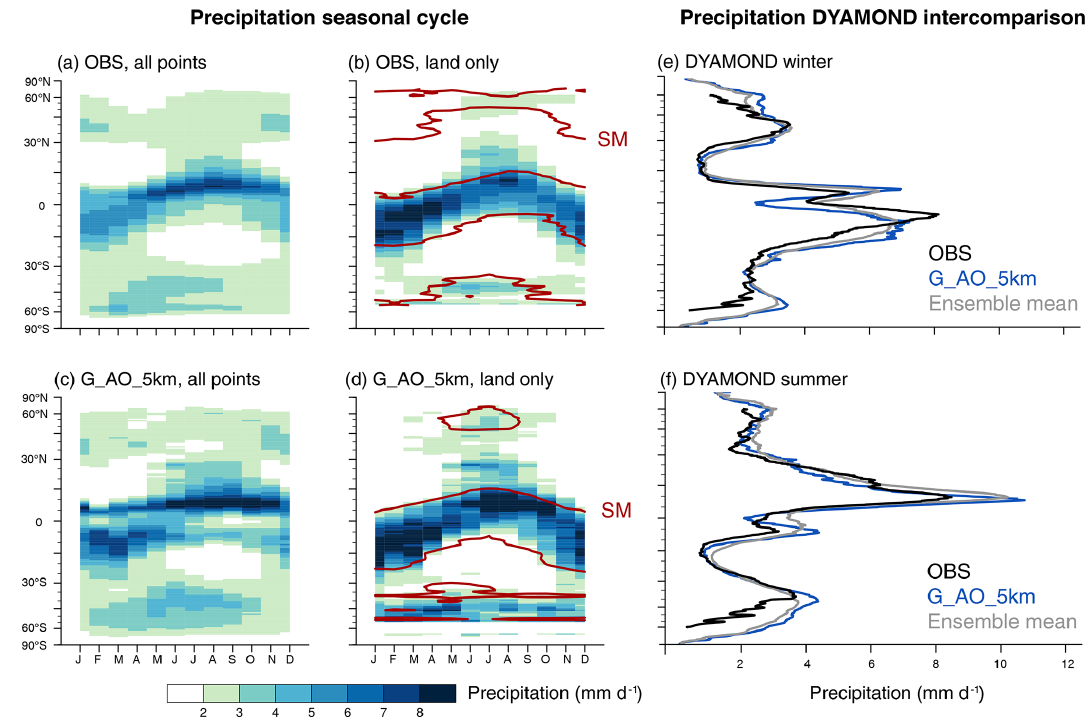
Figure 6. Seasonal evolution of zonal mean precipitation (shading) from (a–b) observations and (c–d) G_AO_5km. In panels (b) and (d) , only land points are included with the soil moisture (SM) contour overlaid in brown (1.5cm in b and 1cm in d given their distinct magnitude). Observations are from the Global Precipitation Climatology Project (GPCP, grid spacing of 2.5 ◦ , Adler et al., 2018) and from the European Space Agency Climate Change Initiative (ESACCI, Dorigo et al., 2017) soil moisture (grid spacing of 0.25 ◦ ) averaged over the years 2010–2019. For G_AO_5km the January and February values are from 2021. Panels (e) – (f) show the zonal mean precipitation from (e) the DYAMOND winter and (f) DYAMOND summer intercomparison study including the ensemble mean of participating